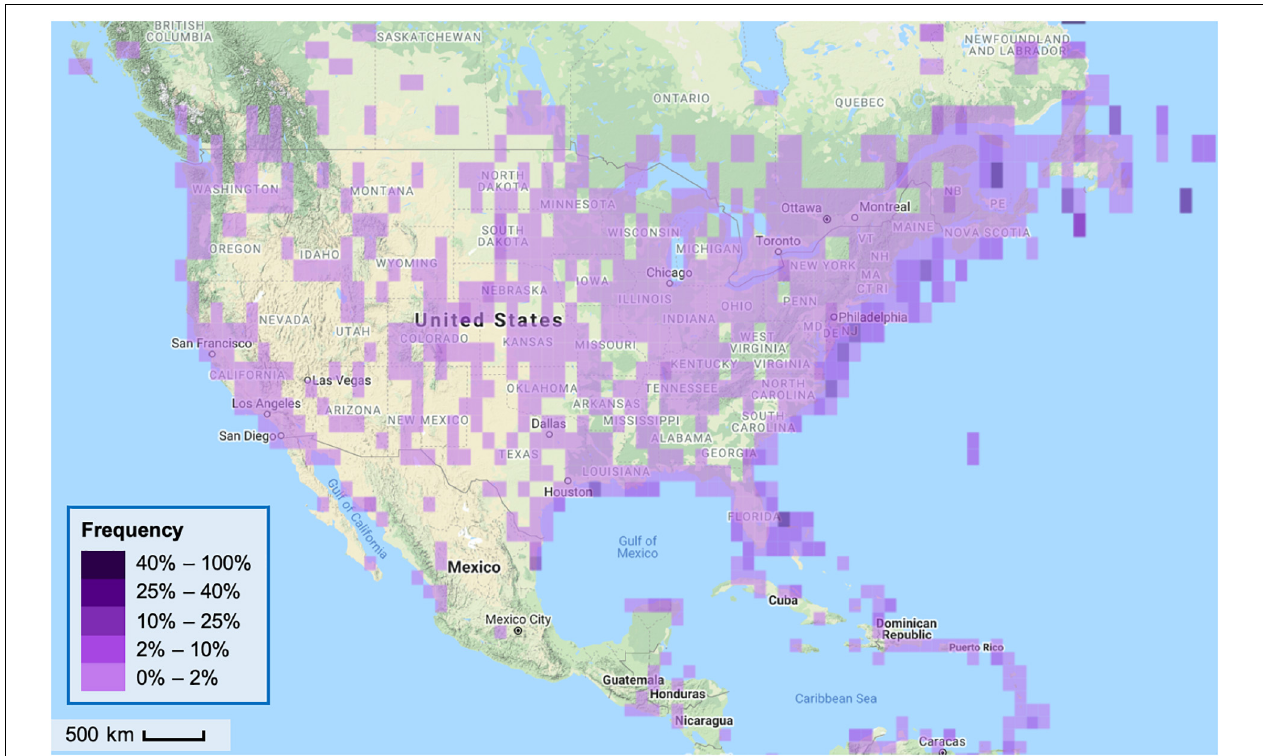
FIGURE 1 | eBird map of LBBG sightings in part of North America. The frequency is the percentage of submitted checklists from that region in which a LBBG was recorded. Image provided by eBird (www.ebird.org) and created November 10, 2020.